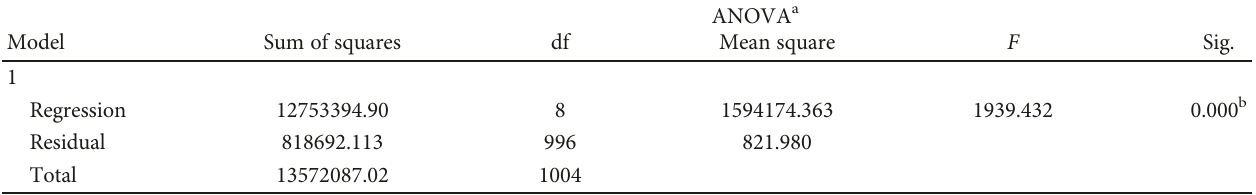
Table 10: ANOVA results for EGT training.